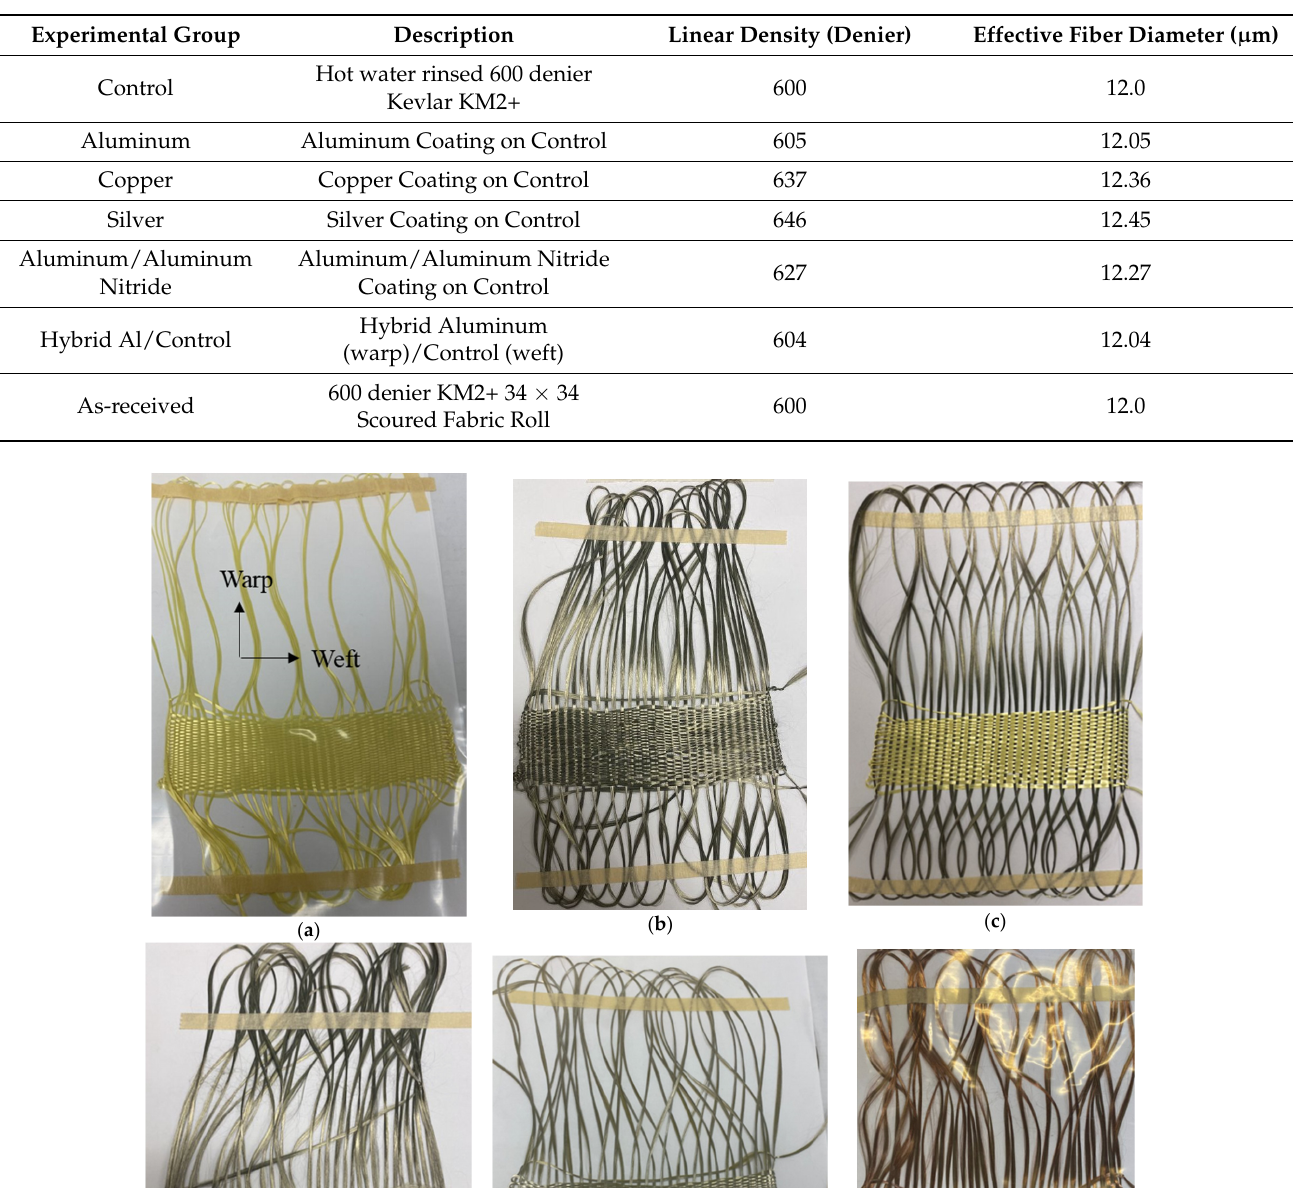
Table 1. Coated and uncoated experimental groups.